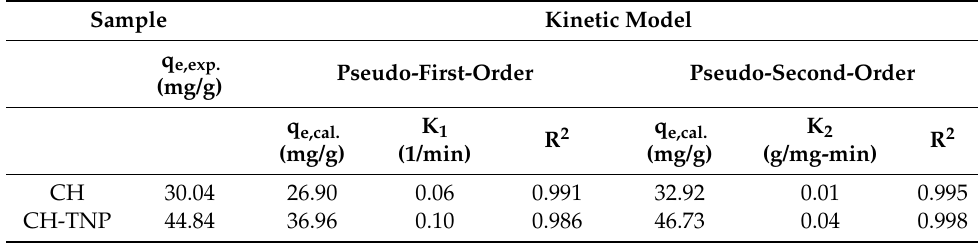
Table 4. Kinetic modeling parameters for Cu(II) adsorption.